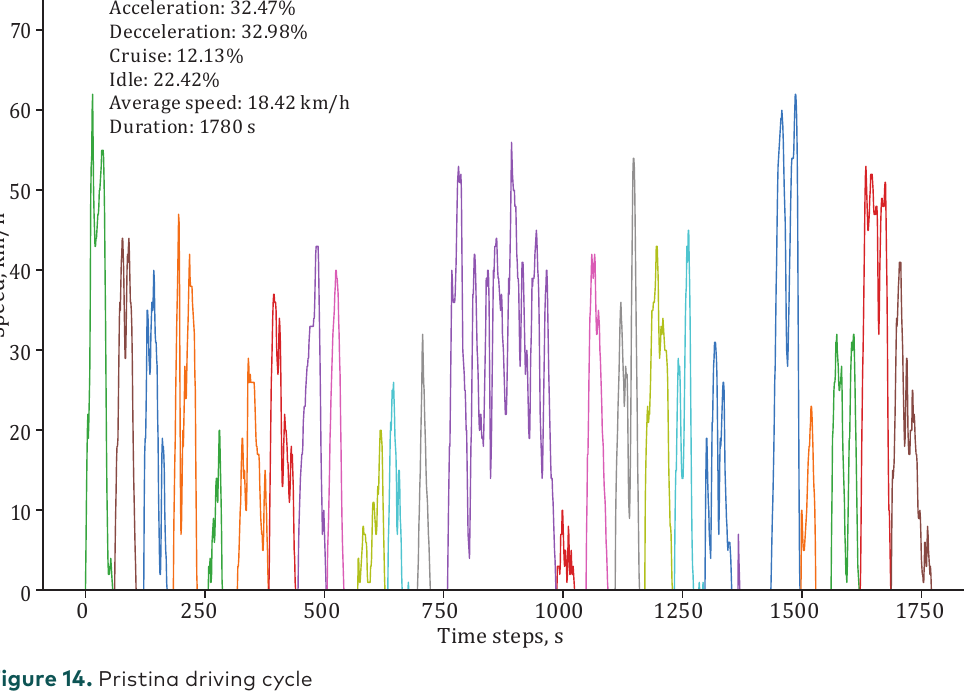
is 17.97 km/h. Micro-trips were extracted from basic data using the special algorithm in Python, and 780 micro-trips were obtained. Using the K-mean method, out of 780 micro-trips, only 25 were selected to develop the final driving cycle. These micro-trips are shown in Figure 15. The final driving cycle was obtained, and the duration was 1780 seconds (Figure 14). The assessment parameters of final Pristina driving cycle are: the percentage of time in acceleration mode is 32.47%, the percentage of time in deceleration mode is 32.98%, the percentage of time spent in idle mode is 22.42%, the percentage of time spent in cruising mode is 12.13% and the average speed for the entire trip is 18.42